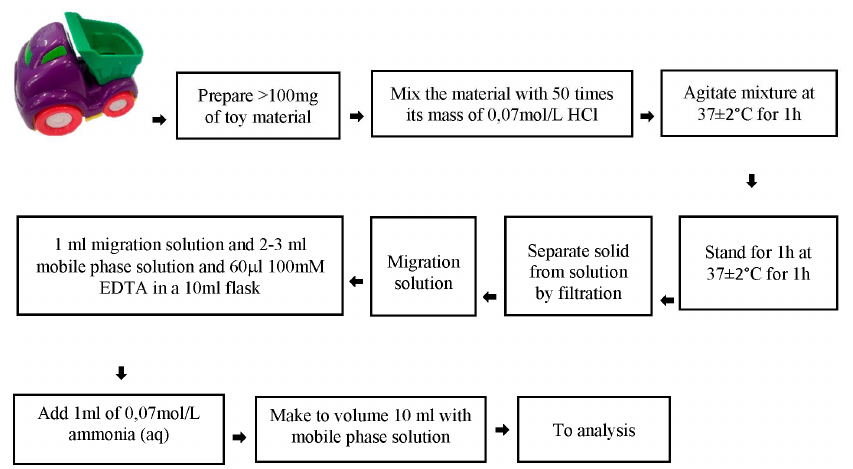
Figure 3. The sample preparation procedure for chromium speciation analysis.